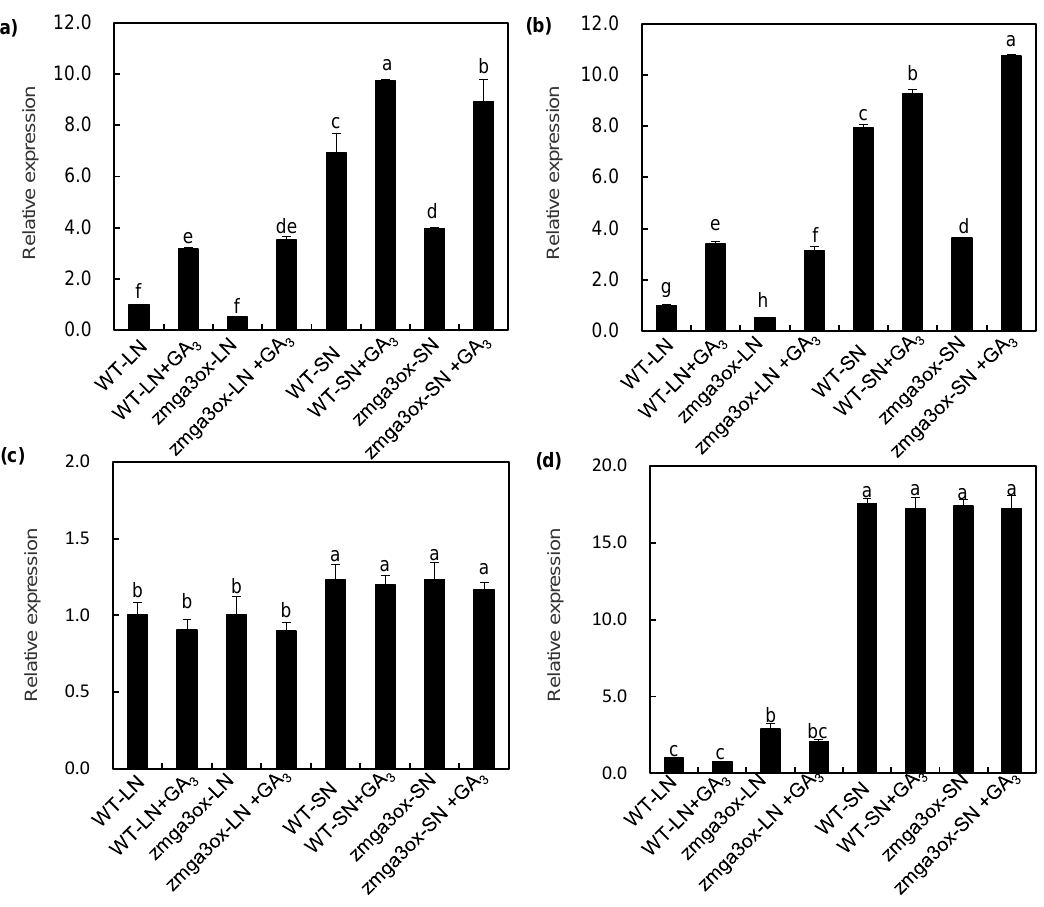
Figure 5. Effects of exogenous GA 3 on the expression levels of ZmNRT2.1 ( a ), ZmNRT2.2 ( b ), ZmNPF6.3a ( c ) , and ZmNPF6.3b ( d ) in wild-type and zmga3ox roots under LN and SN conditions. The roots were harvested at 72 h after GA 3 treatment under LN and SN conditions. Values were the means ± SD ( n = 3). Different letters indicated significant difference calculated by Fishe’s LSD ( p < 0.05).